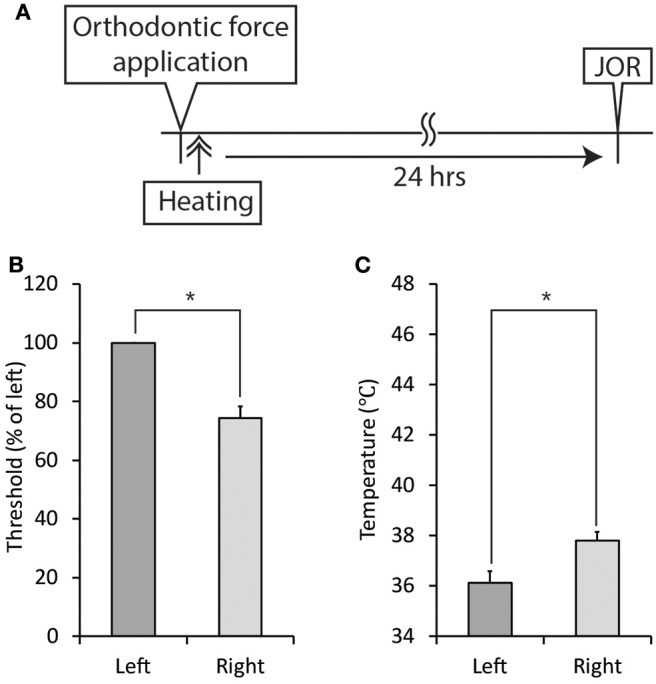
Effect of thermal stimulation immediately after the application of orthodontic force on the development of orthodontic treatment-induced excitation of the jaw-opening reflex. (A) Experimental procedure for the application of orthodontic force, thermal stimulation, and the evaluation of jaw-opening reflex excitability. (B) Thermal stimulation (30 s, 45°C) did not alter the right-side threshold for inducing the jaw-opening reflex on D1. (C) Thermal stimulation (30 s, 45°C) did not alter the temperature of the right molar gingival sulcus on D1. Heating: thermal stimulation. JOR, evaluation of jaw-opening reflex excitability. Paired t-test, *p < 0.05.